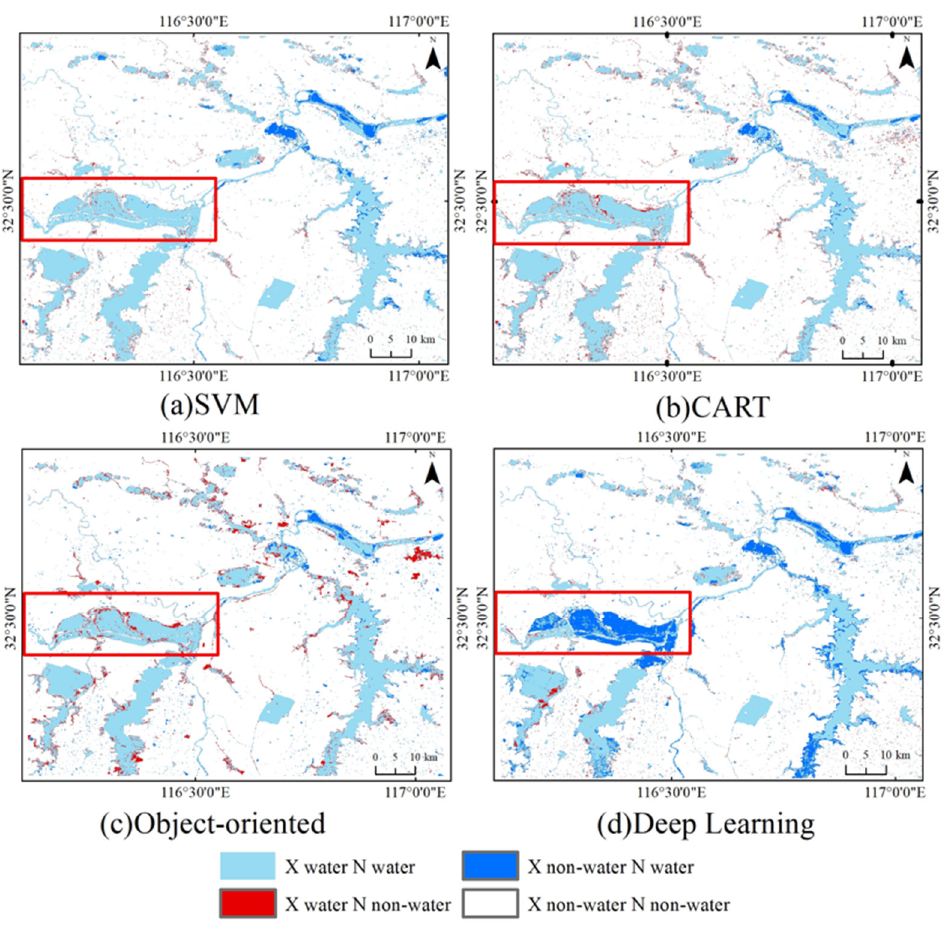
Figure 4. Superimposed comparison of different methods and NDWI water extraction results in some basins of Huai River. ( a ) SVM; ( b ) CART; ( c ) Object-Oriented; ( d ) Deep Learning (the water distribution obtained by the four methods of SVM, CART, object-oriented, and deep learning are superimposed with the NDWI extraction results. X represents the extraction result of the method used in this figure and N represents the extraction result of NDWI. The four pixel types will be generated: X water N water, X water N non-water, X non-water N water, and X non-water N non-water.).